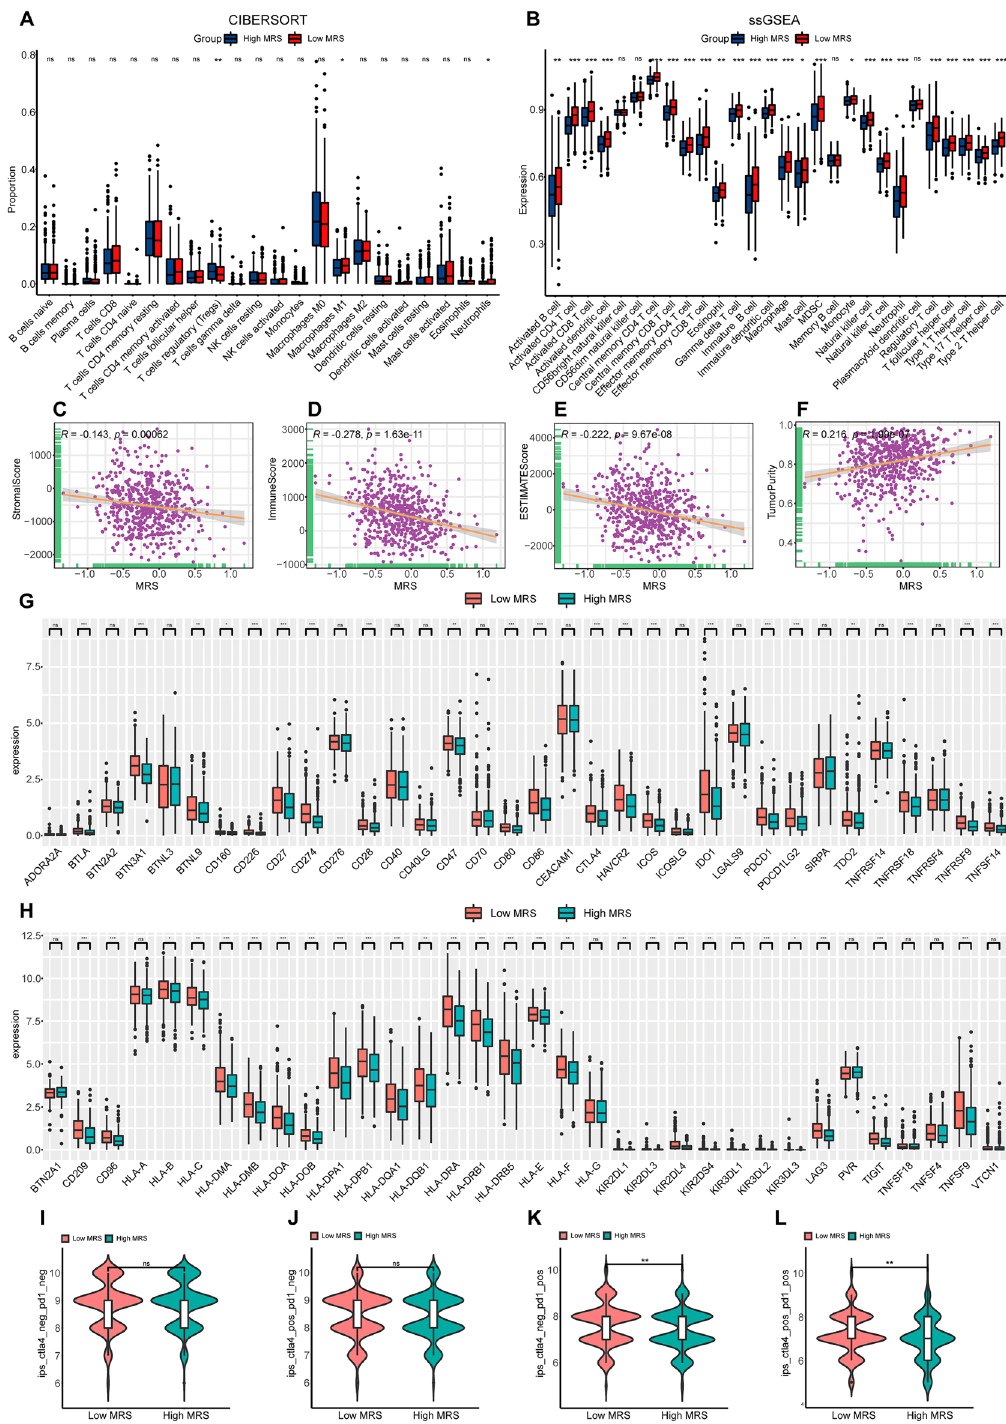
Figure 5. The immune characteristics of different MRS patient subgroups. ( A ) CIBERSORT analyses were used to assess immune cell infiltration in the indicated MRS subgroups. ( B ) ssGSEA analyses were used to assess immune cell-related gene expression in the indicated MRS subgroups. ( C – F ) Analyses of the relationship between MRS scores and stromal score ( C ), immune score ( D ), estimate score ( E ), and tumor purity ( F ). ( G , H ) The association between MRS subgroups and the expression of immune checkpoint genes. ( I ) The relationship between MRS subgroups and predicted immunotherapy outcomes. ( J – L ) The relationship between different MRS subgroups and predicted treatment outcomes for CTLA4 ( J ), PD-1 ( K ), or CTLA4 + PD-1 ( L ) targeted treatments. *P < 0.05; **P < 0.01; ***P <